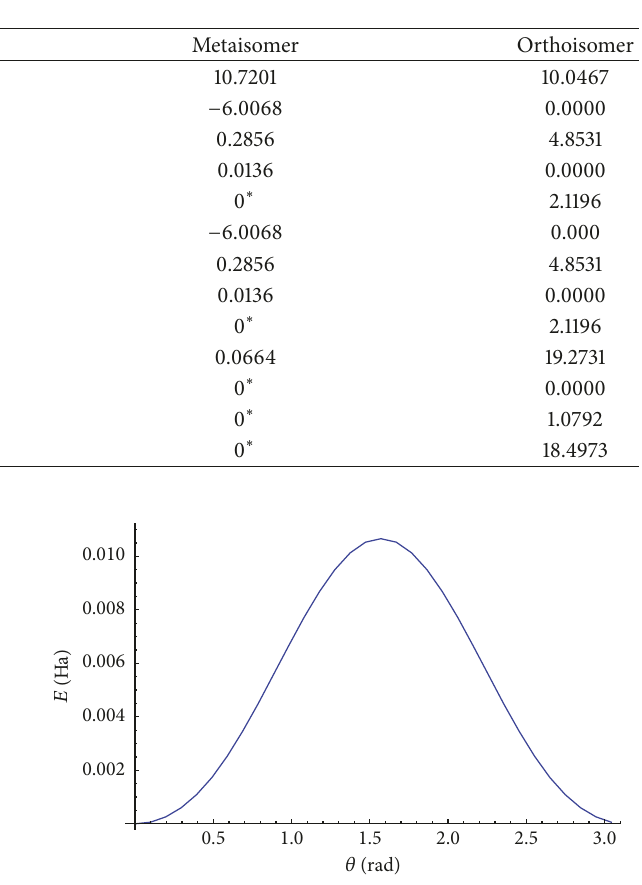
Figure 4: Plot of the electronic energy above the minimum for the paraisomer as a function of the torsional angle of the NO 2 groups, using the computed Legendre polynomial expansion.